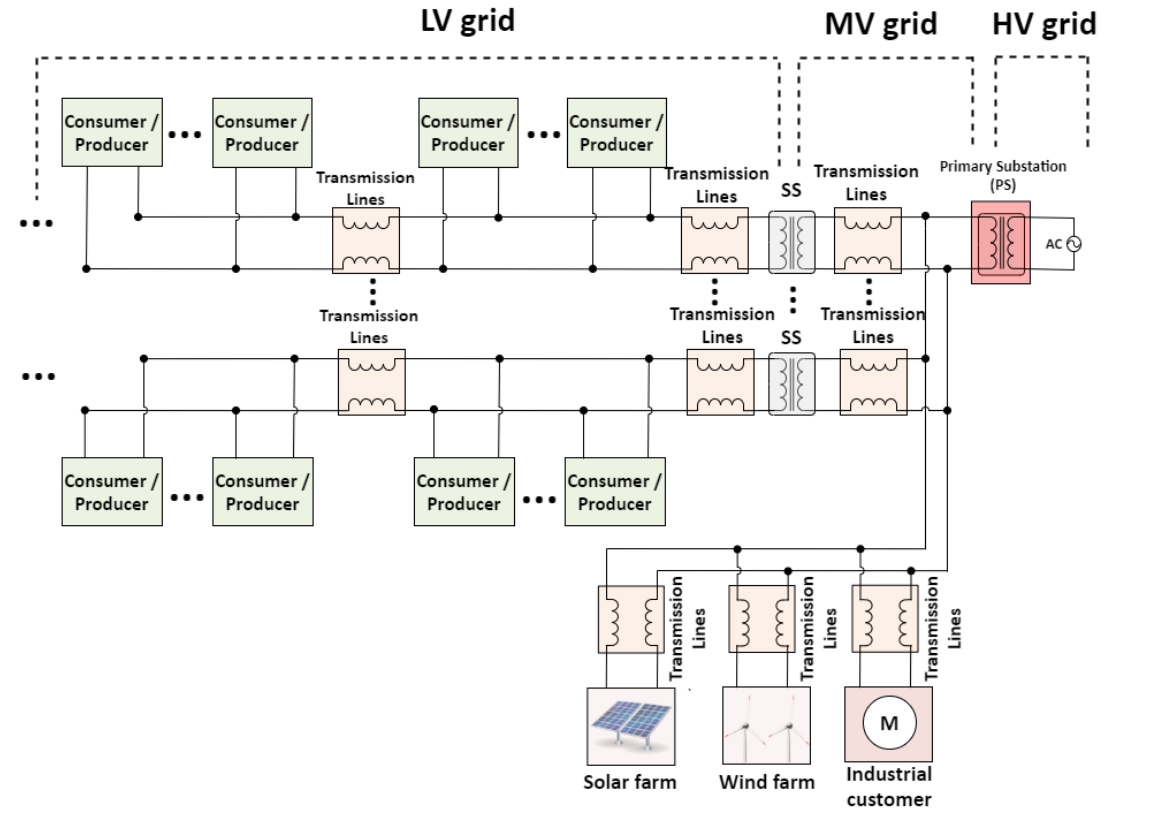
Figure 1. An example energy grid